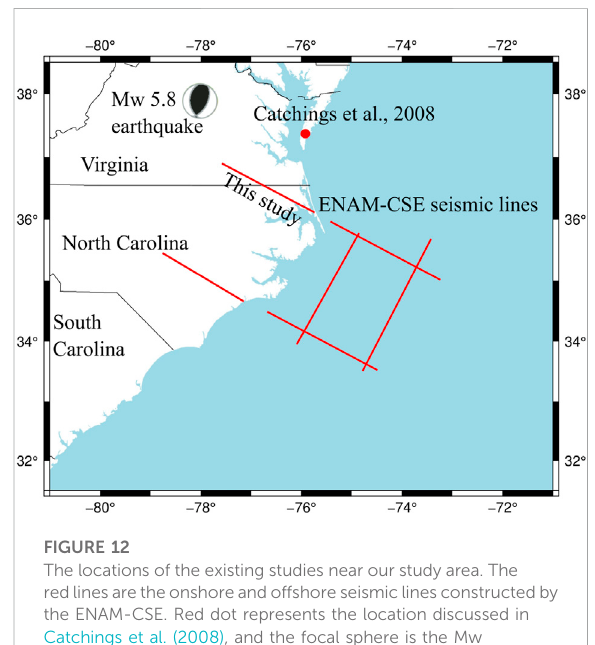
FIGURE 12 The locations of the existing studies near our study area. The redlinesaretheonshoreandoffshoreseismiclinesconstructedby the ENAM-CSE. Red dot represents the location discussed in Catchings et al. (2008), and the focal sphere is the Mw 5.8 earthquake in